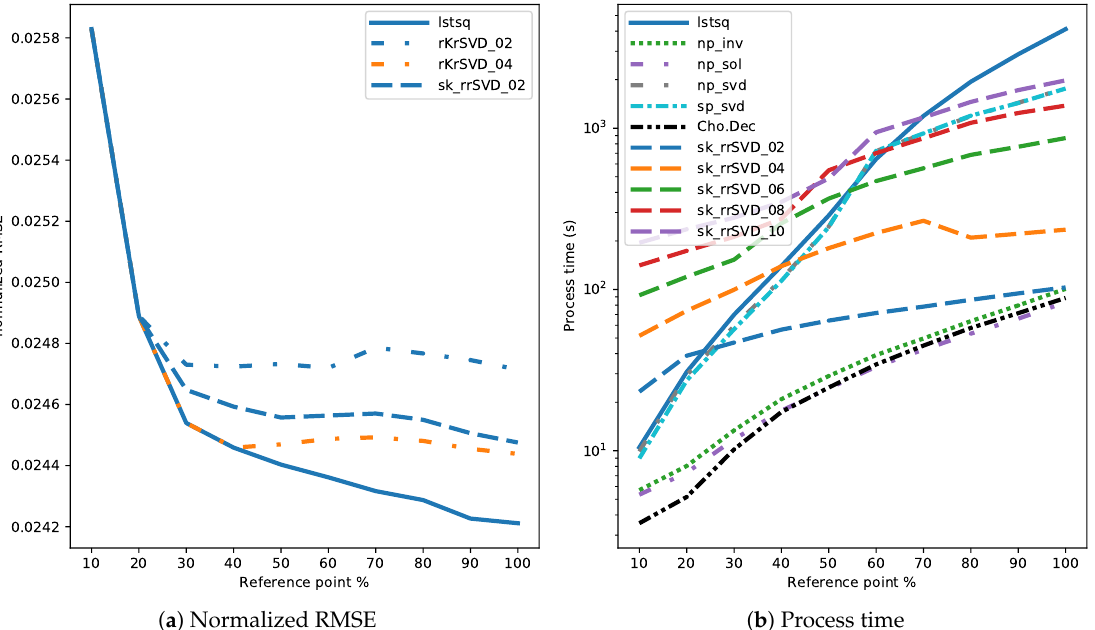
Figure 3. Normalized RMSE values ( a ) and process time in seconds taken to compute Equation (1) ( b ) as a function of reference point percentage for the Computer Activity dataset. In ( a ), only methods that at any reference point percentage differ from Lstsq with Kruskal–Wallis H test are shown along Lstsq